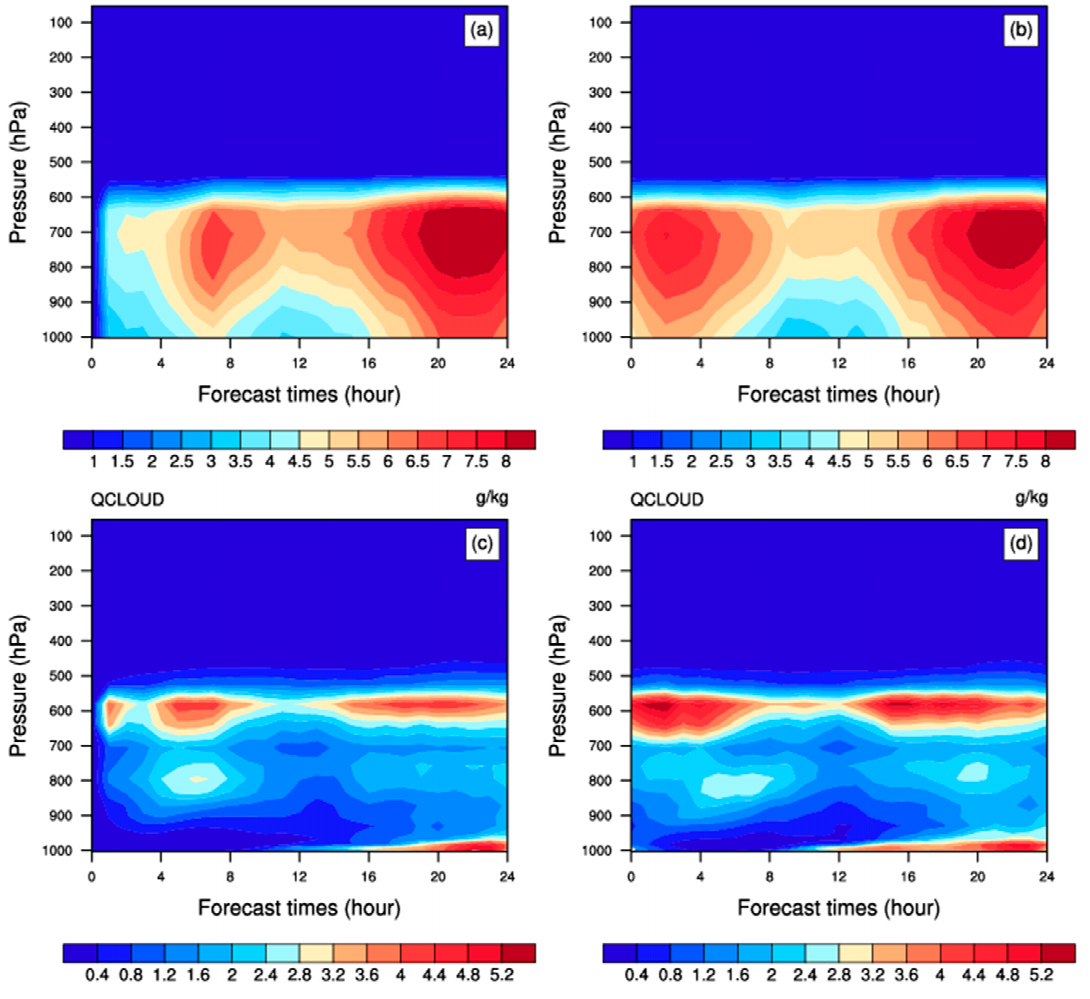
Figure 15. The vertical structure of rainwater mixing ratio ( a , b ) and cloud water mixing ratio ( c , d ) as the forecast time leads for CON ( a , c ) and POD ( b , d ).